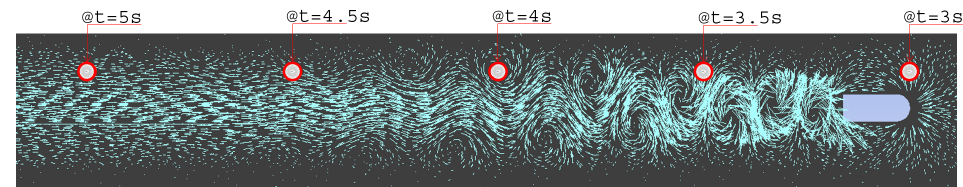
Figure 13. Velocity vector of the car wake taken in stationary zone adjacent to the layering zone.